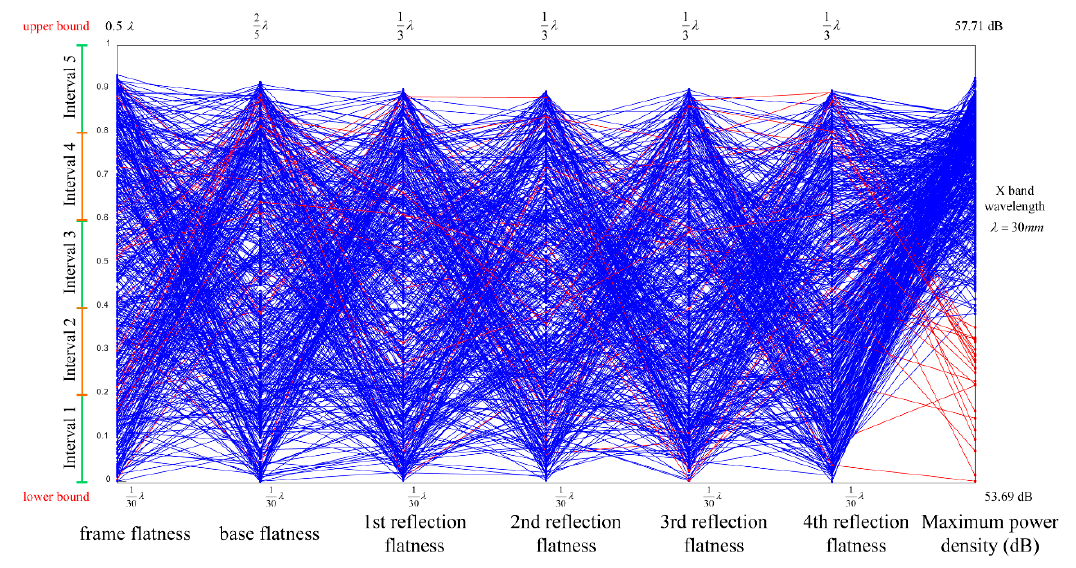
Figure 9. The parallel coordinates plot of 500 sets of samples.